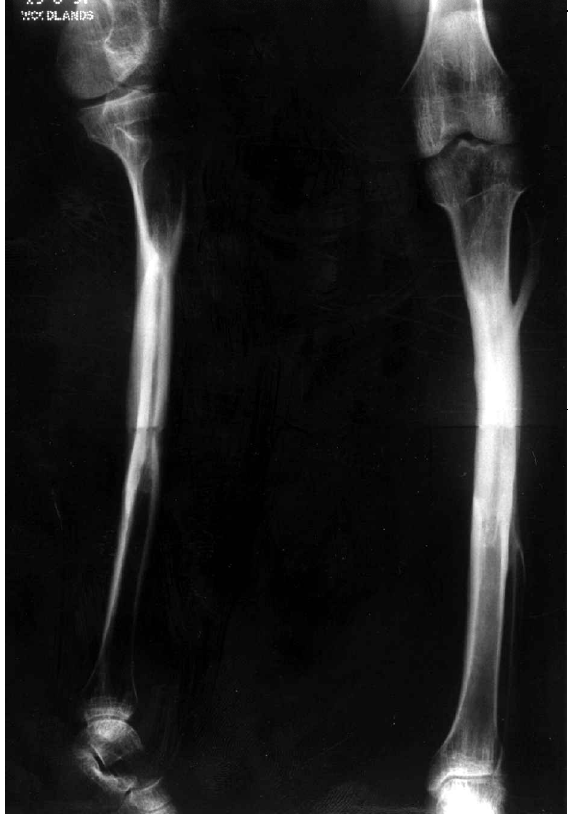
Fig. 2. Anteroposterior and lateral radiographs for the same patient in Fig. 1, almost 8 years following the second stage procedure. It shows complete incorporation of the graft with the tibia, as well as hypertrophy of the graft itself acquiring the size and shape of the